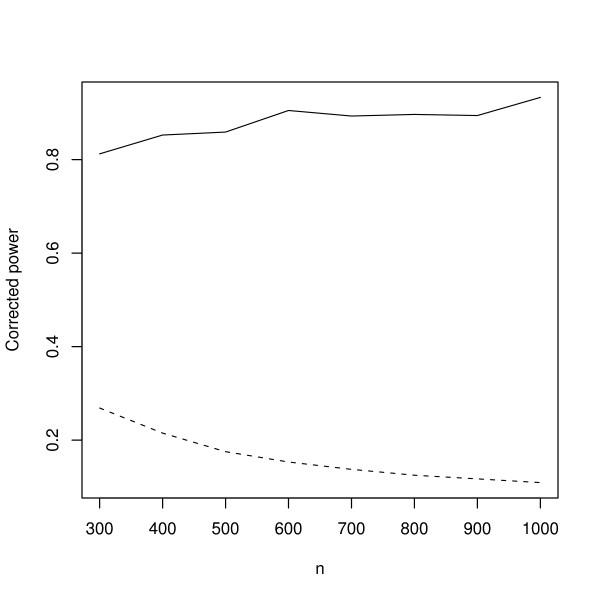
Corrected power curve. The full line represents the proposed VAR and the dashed line represents the standard VAR. It was performed 15,000 Monte Carlo simulations (model described in simulation II) for each n where n varied from 300 to 1,000 in steps of 100. n: sample size. P-value and standard deviation of measurement error were set to 0.05 and 0.5, respectively.